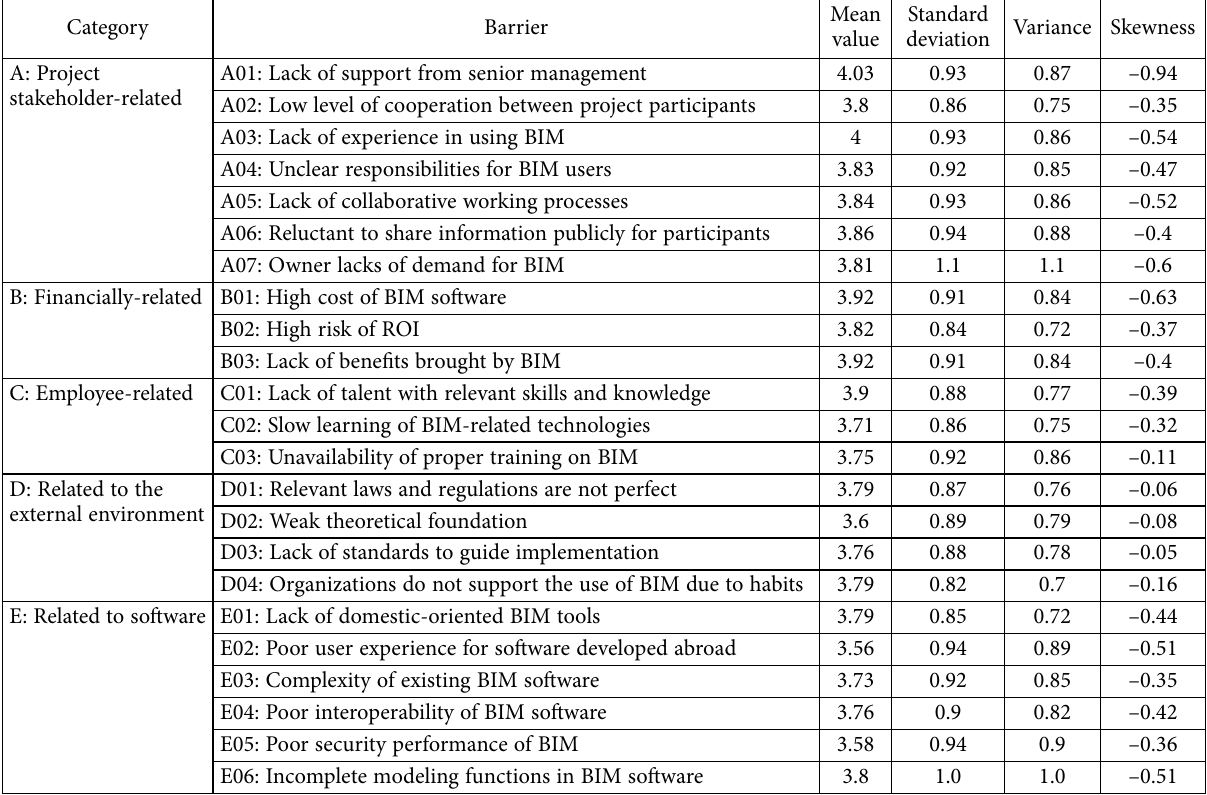
Table 4. Statistical analysis of factors that hinder the application of BIM for building industrialization Category